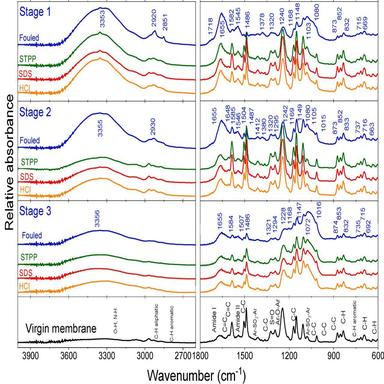
ATR-FTIR spectra of the fouled membranes (blue) from Stage 1 (first row), Stage 2 (second row), and Stage 3 (third row), with membranes after cleaning with STTP (green), SDS (red), and HCl (orange) and the virgin membrane spectrum (bottom, black). (For interpretation of the references to color in this figure legend, the reader is referred to the Web version of this article.)